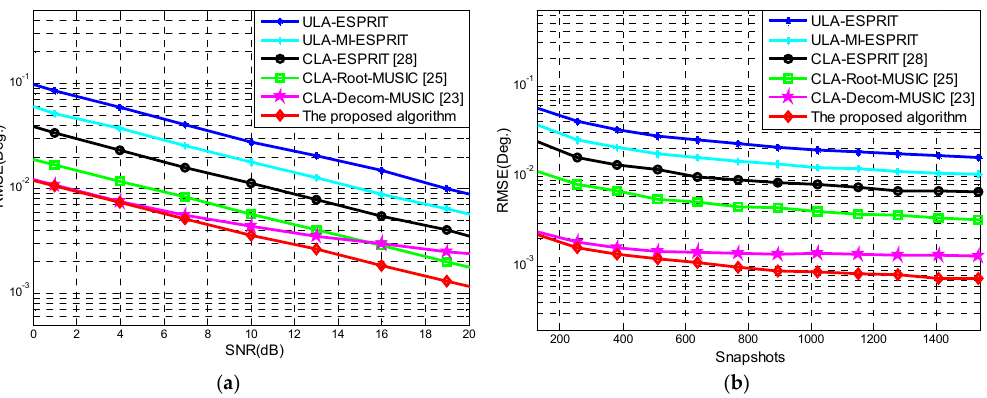
Figure 5. DOA estimation precision analysis: ( a ) Root mean square error (RMSE) of DOA estimation versus the signal-to-noise ratio (SNR), and ( b ) RMSE of DOA estimation versus snapshots. With increasing SNR or snapshots, the DOA estimation RMSE of the algorithms decreased rapidly. Compared with the ULA, the DOA estimation precision of CLA was significantly better.